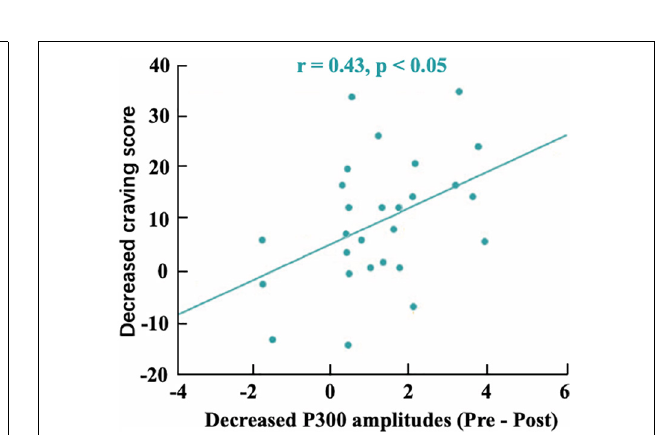
FIGURE 9 | The accuracy of the classifier for each participant. Horizontal line: average; error bar: SE.